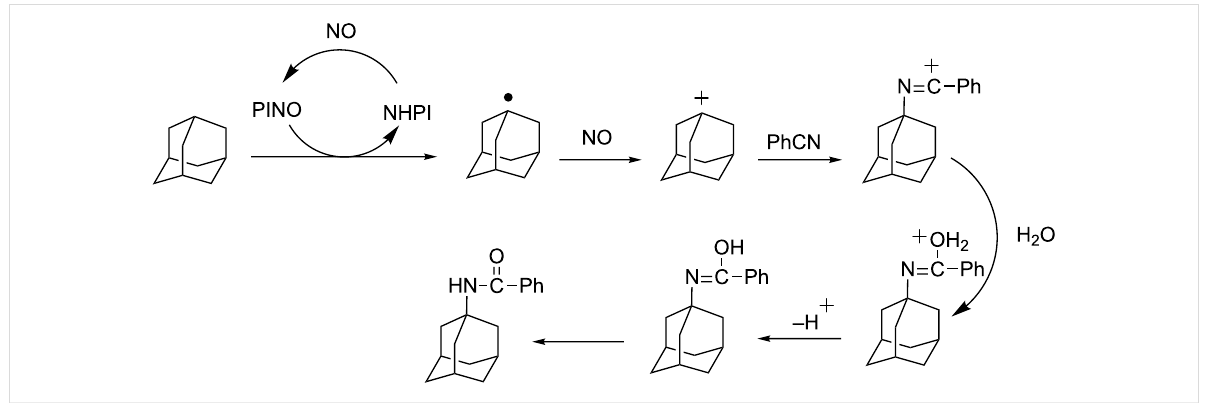
Scheme 7: NHPI-catalyzed reaction of adamantane under NO atmosphere.